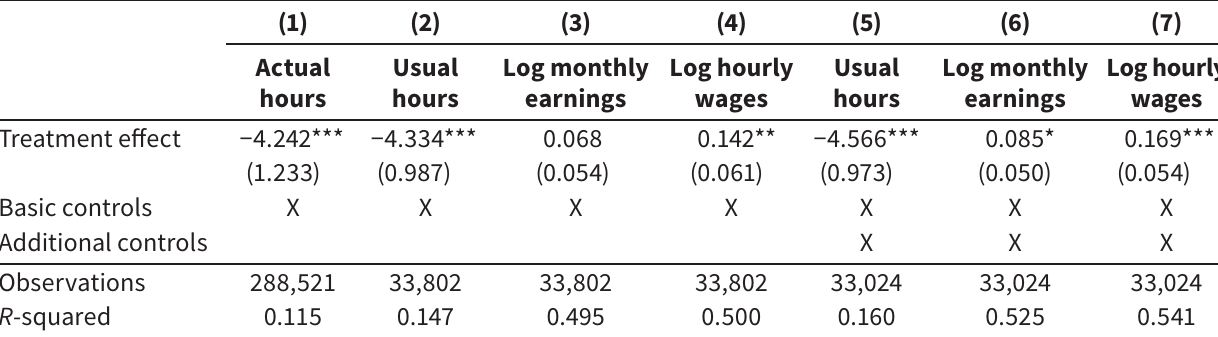
Individual-level estimation